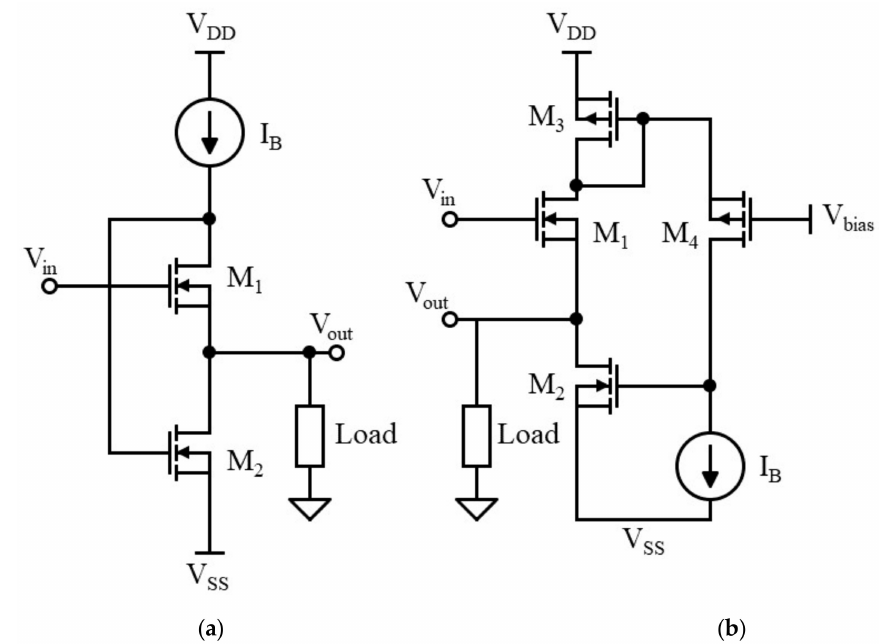
Figure 1. FVF structures: ( a ) standard NMOS FVF, ( b ) class AB